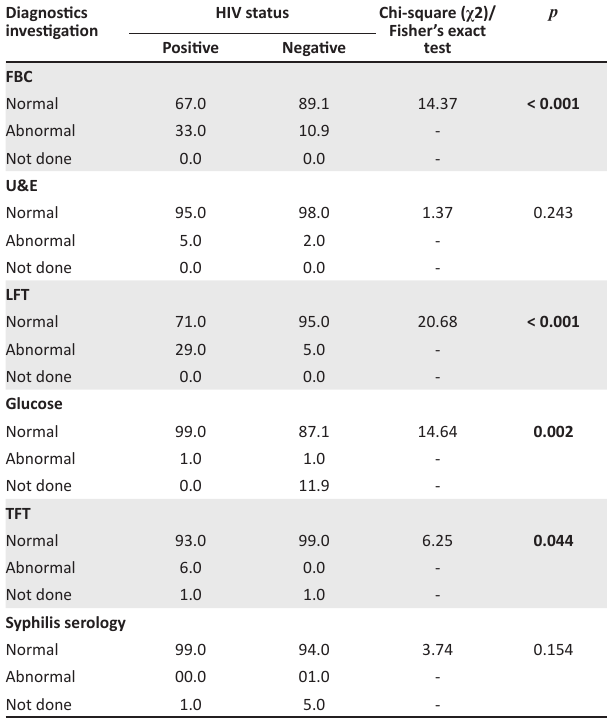
TABLE 5: Human immunodeficiency virus status and diagnostic investigation ( n =